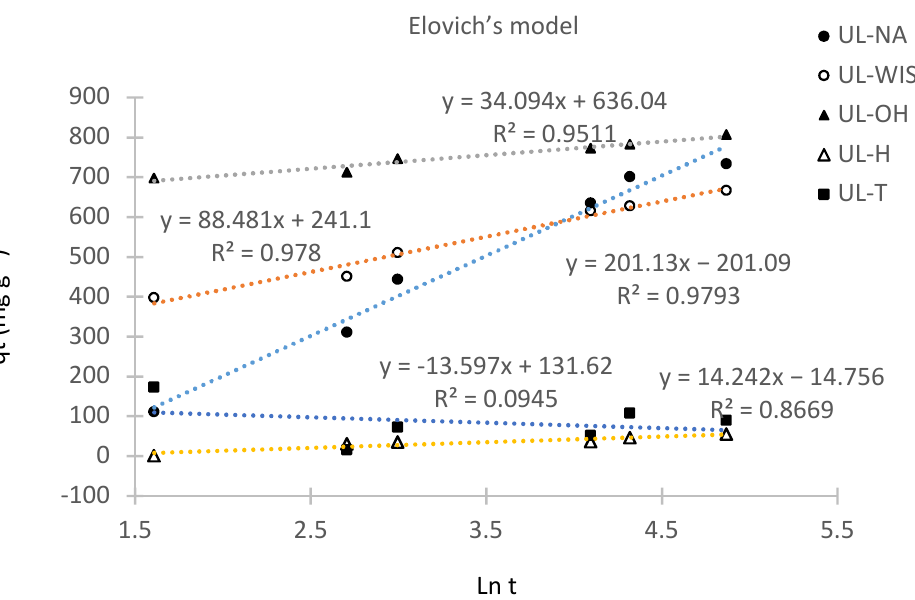
Figure 13. Elovich’s model of MB adsorbed by dry U. Lactuca biomass. Experimental conditions: 5 g L − 1 adsorbent concentration, pH = 8, T = 25 ◦ C, C 0 (MB) = 16 mg L − 1 .